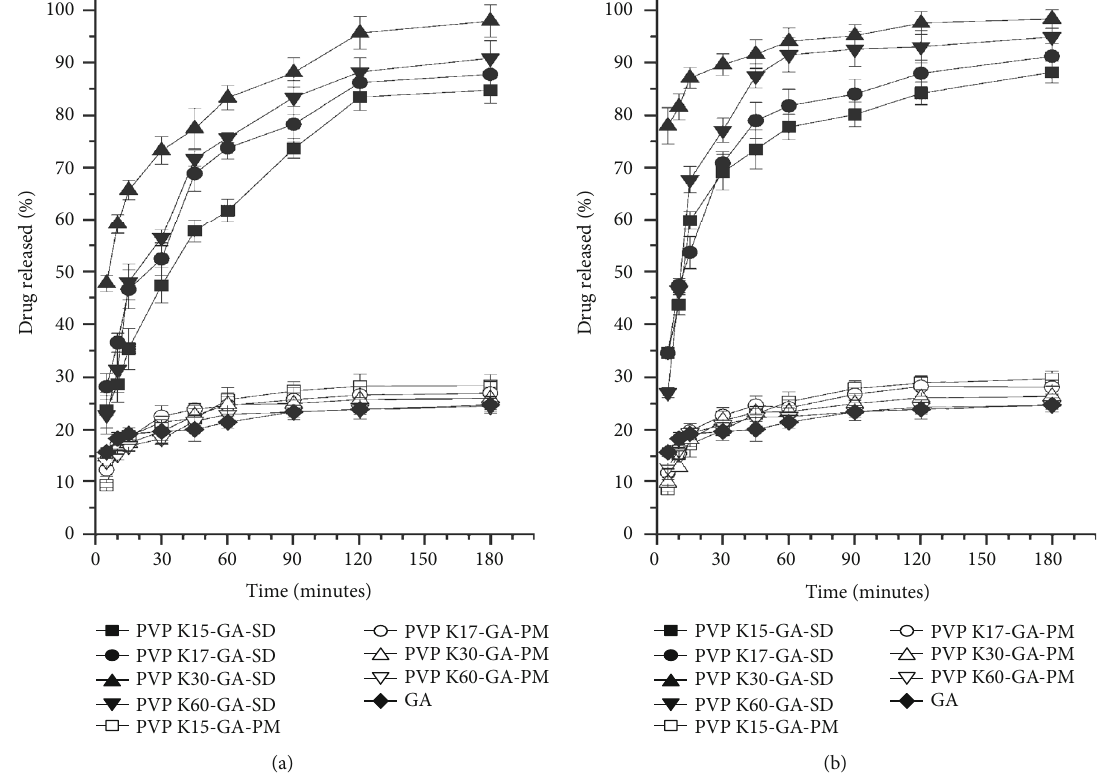
Figure 2: Dissolution pro fi les of pure GA, PVP-GA-SDs, and PVP-GA-PMs in phosphate bu ff er solution. (a) PVP/GA weight ratio of 4 :1. (b) PVP/GA weight ratio of 8